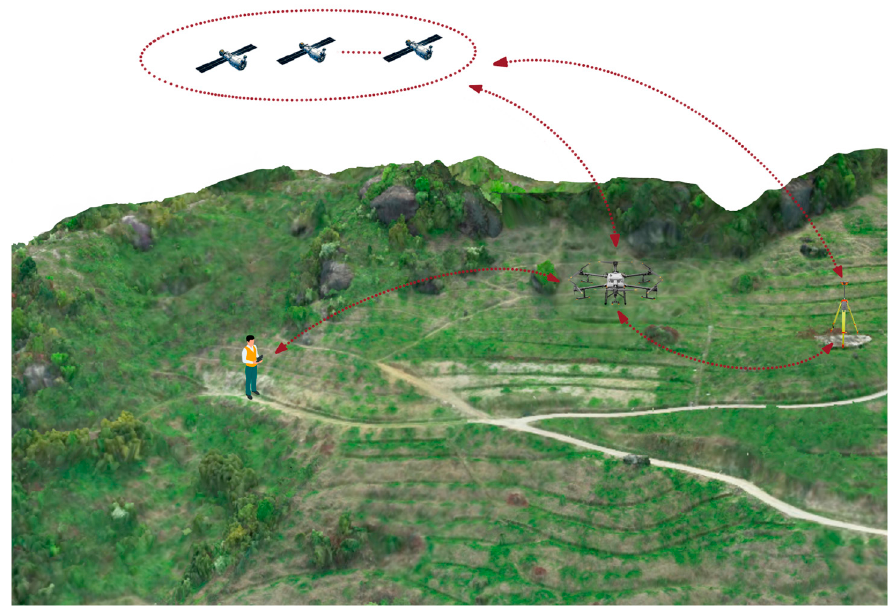
Figure 1. RTK operating principle.